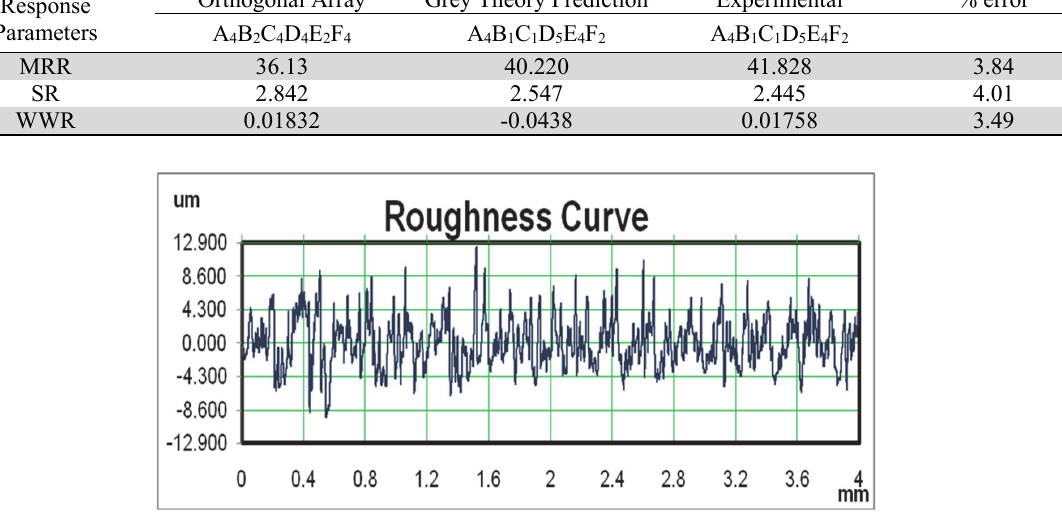
A 4 B 1 C 1 D 5 E 4 F 2 process parameters and actual experimental results obtained at grey theory predicted optimal parameters setting in WEDM of Inconel 825 alloy workpiece material. Performance results using the initial orthogonal array and optimal grey predicted process parameter Response